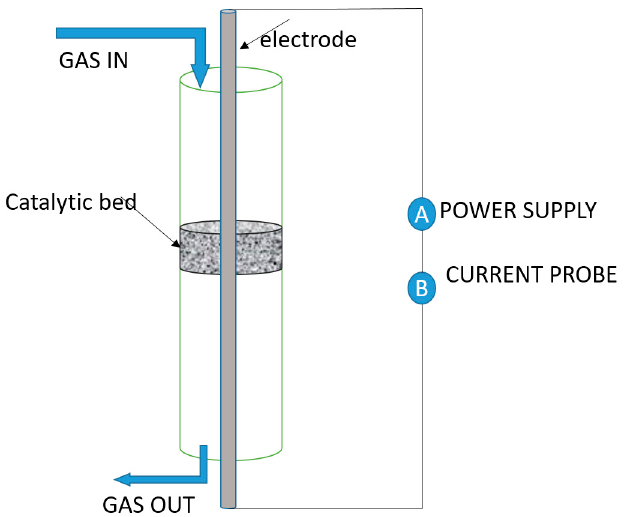
Figure 4. Schematic representation of the experimental setup and electrified catalyst. Adapted from [106].